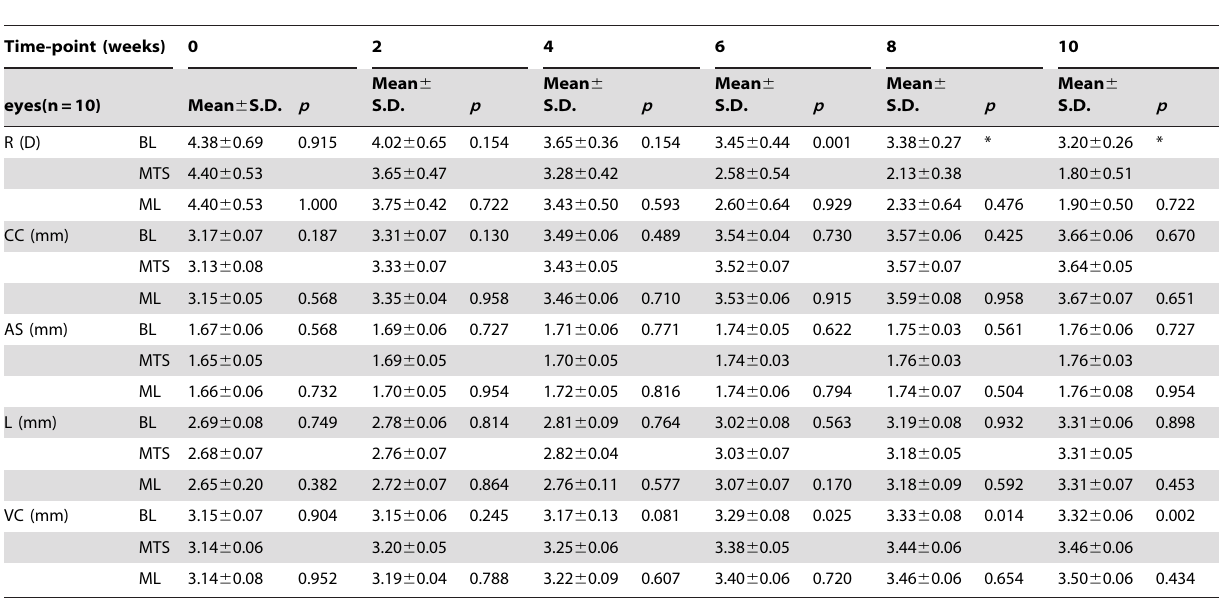
Table 1. Mean biometric results from guinea pigs reared in the three groups and the comparisons between the ML or BL and the MTS groups at each time point from 0 to 10